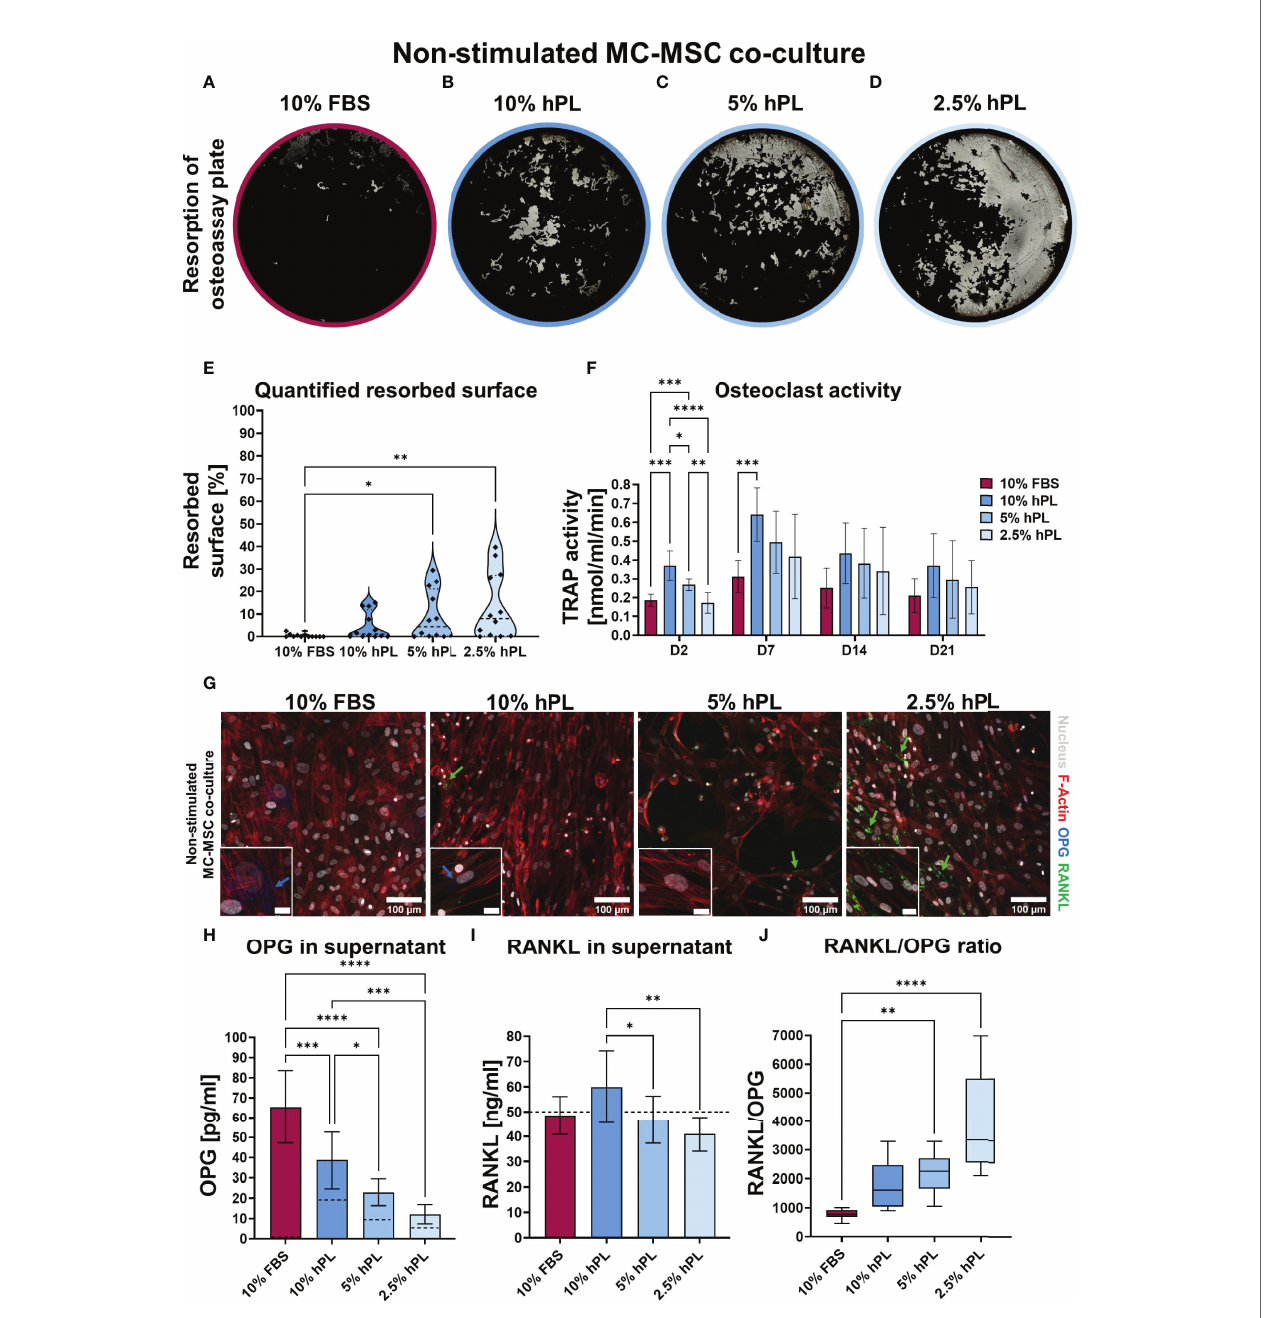
FIGURE 3 | (A – D) Von Kossa stained decellularized resorption plates of MC-MSC co-cultures. (E) Quanti fi cation of resorbed area, p <0.05 (Kruskal-Wallis and Dunn ’ s post hoc tests). (F) TRAP activity quanti fi cation, p < 0.05 for culture time, culture condition, no interaction effect (two-way ANOVA and Turkey ’ s post hoc tests within each time point). (G) Micrographs of MC-MSC co-cultures stimulated to undergo osteoclastic differentiation, stained for F-Actin (red), the nucleus (gray), OPG (blue) and RANKL (green). Images were taken at locations rich of MSCs to detect their in fl uence on OPG and RANKL production. Scale bar in insert is 20 µm. (H) Quanti fi cation of OPG in supernatant, dashed lines represents concentration in the medium control, p < 0.05 (one-way ANOVA and Turkey ’ s post hoc tests). (I) Quanti fi cation of RANKL in supernatant, dashed line represents concentration exogenous RANKL added to the medium, p < 0.05 (one-way ANOVA and Turkey ’ s post hoc tests). (J) RANKL/OPG ratio in supernatant, p < 0.05 (Kruskal-Wallis and Dunn ’ s post hoc tests). Asterisks in fi gures represent results of post hoc analyses (* p < 0.05, ** p < 0.01, *** p < 0.001, **** p < 0.0001). fetal bovine serum (FBS), human platelet lysate (hPL), monocytes (MCs), mesenchymal stromal cells (MSCs), tartrate resistant acid phosphatase (TRAP), osteoprotegerin (OPG), receptor activator of nuclear factor k B ligand